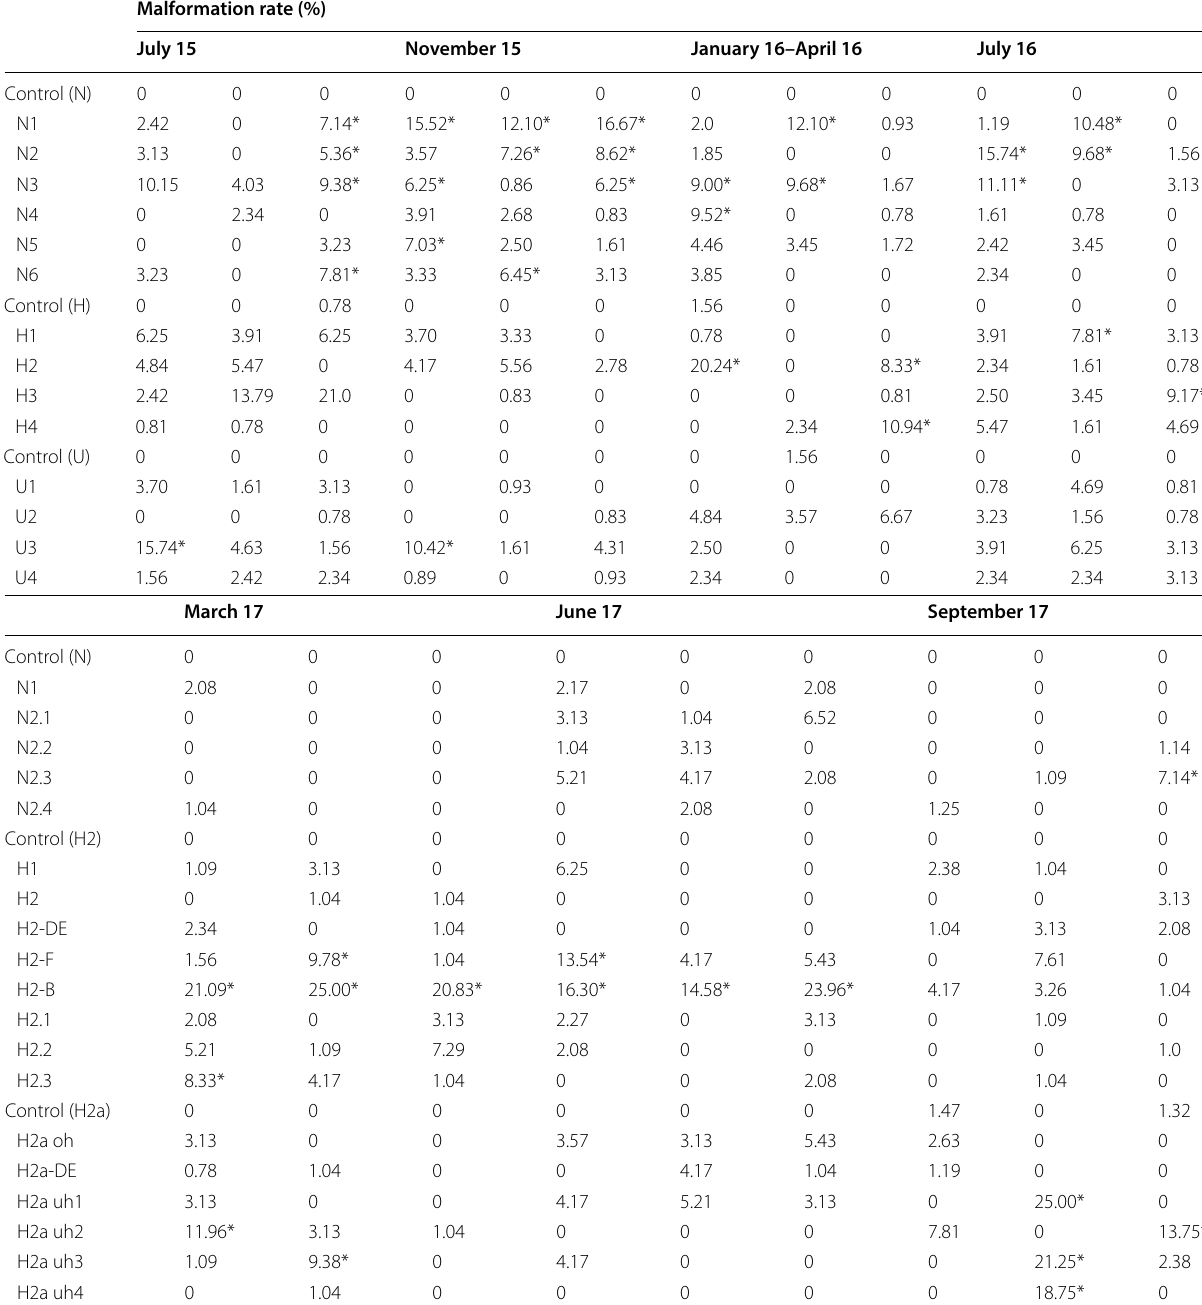
Table 5 Malformation rates at 96 hpf for main and additional sampling sites with three runs per time point